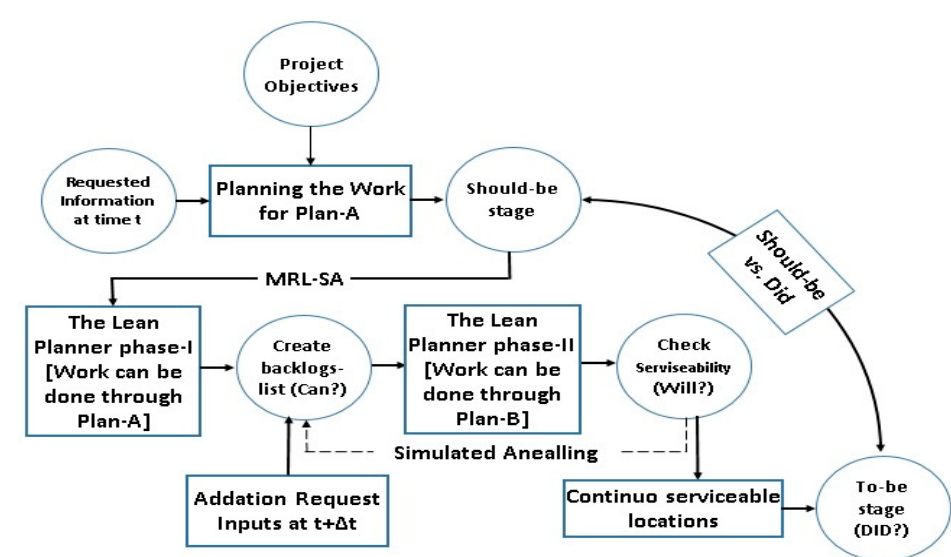
Figure 1. Sequence of activities of plan.